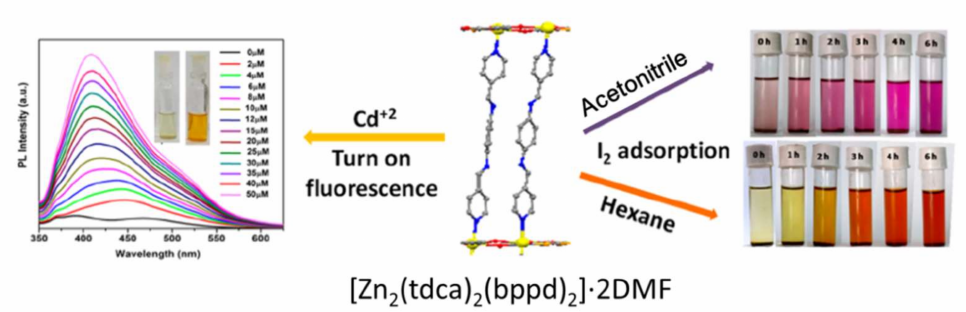
Figure 11. Structure of [Zn 2 (tdca) 2 (bppd) 2 ] · 2DMF, UV-vis spectra of [Zn 2 (tdca) 2 (bppd) 2 ] · 2DMF in acetonitrile suspension upon addition of Cd 2+ at room temperature ( λ ex = 330 nm), and photographs of the iodine release process in acetonitrile and hexane. Adapted from